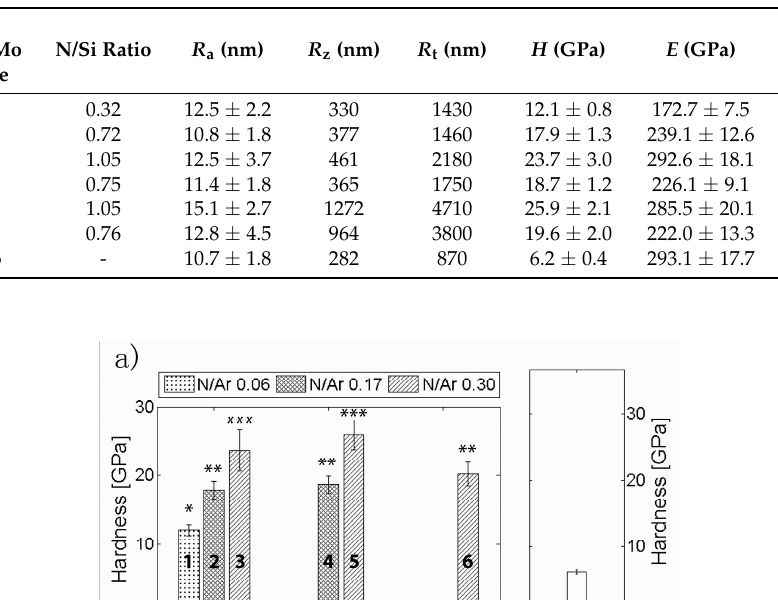
Table 2. Surface roughness, hardness, Young’s modulus, N/Si ratio and H / E ratio for processes 1–6 and the CoCrMo reference.